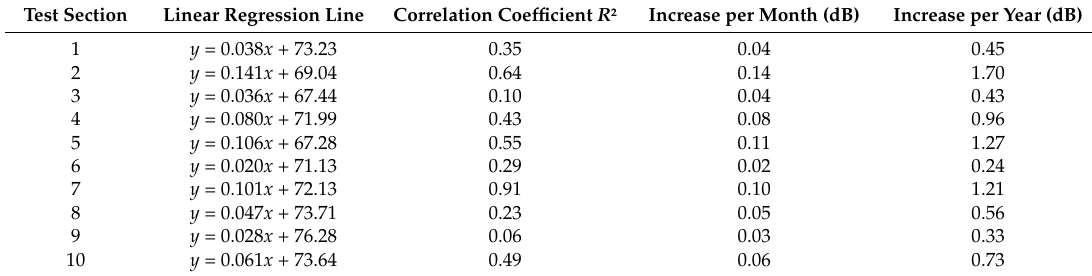
Table 3. Average noise increase per month and per year calculated from the SPB results.